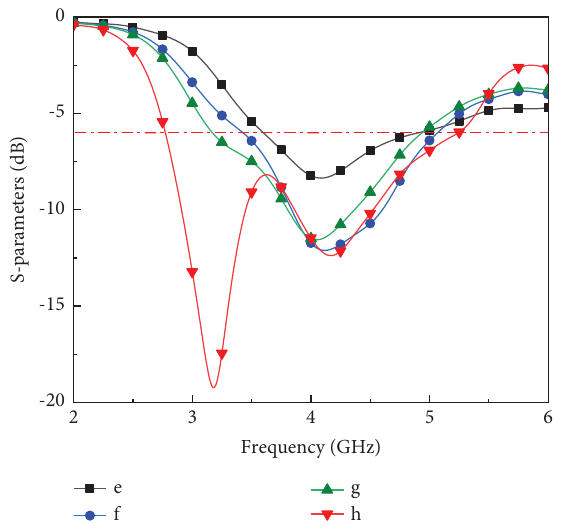
Figure 2: S -parameters of cases e–h.